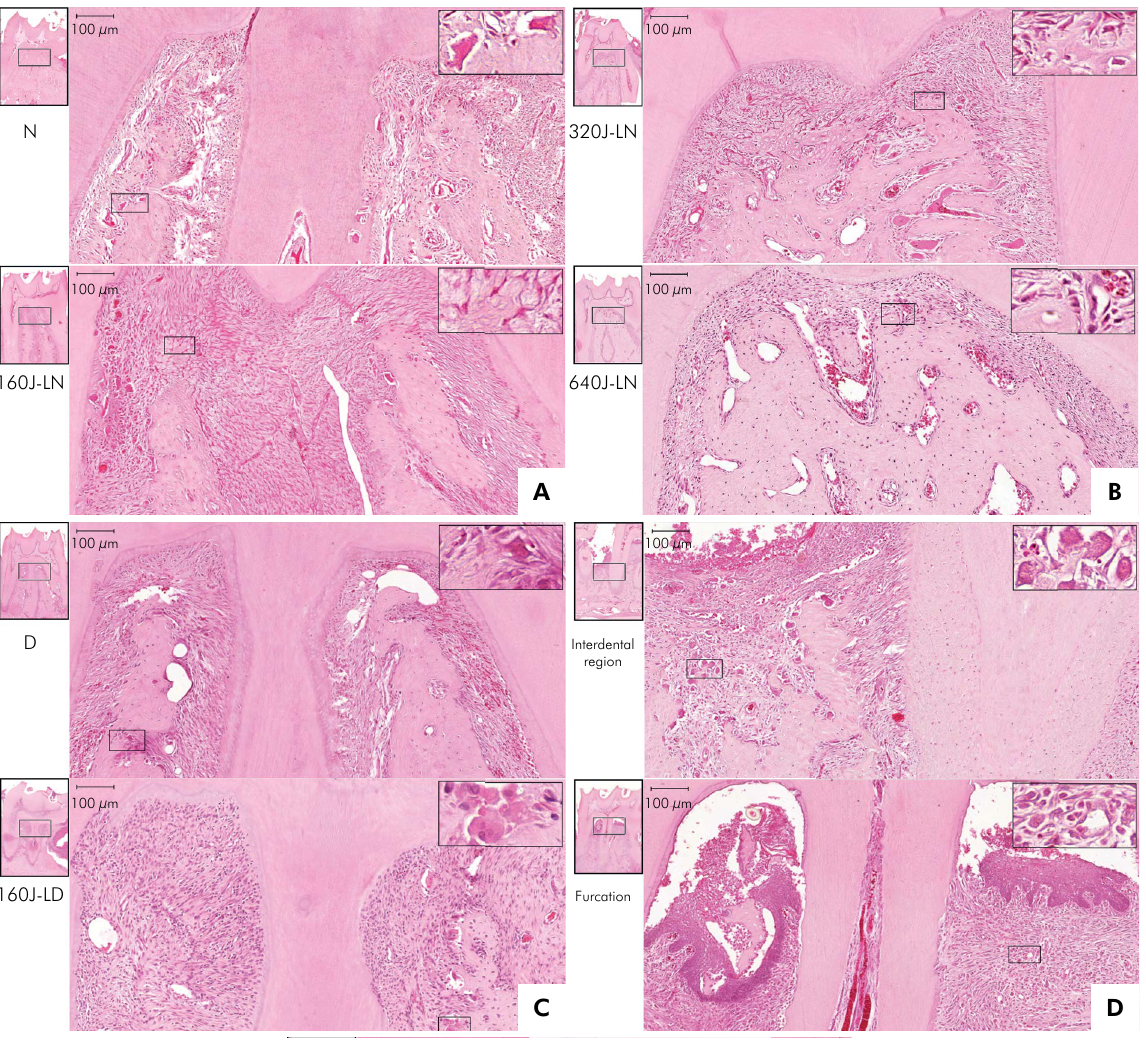
Figure 4. a) Photomicrographs showing furcation region of the orthodontically moved tooth. Intense resorption throughout the alveolar bone tissue and disorganization of the PDL tissue in the N and 160 J-LN groups; and great amount of osteogenic connective tissue showing proliferation and differentiation of news osteoblast from osteogenic cells and presence of osteoid matrix, particularly in the 160 J-LN group. (Hematoxylin and Eosin; Bars = 100 µm). b) Photomicrographs showing furcation region of the orthodontically moved tooth. Newly formed alveolar bone tissue from osteogenic connective tissue and PDL with intense cellularity and disorganized collagen fibers in the 320 J-LN group; and well-preserved and mature alveolar bone tissue, well-organized PDL tissues, and rich vascularization in the 640 J-LN group. (Hematoxylin and Eosin; Bars = 100 µm). c) Photomicrographs showing furcation region of the orthodontically moved tooth. Numerous blood capillaries, interstitial hemorrhage, and disorganized PDL in the D group; and intense osteoclastic activity eliciting accentuated alveolar bone loss in the 160 J-DL group. (Hematoxylin and Eosin; Bars = 100 µm). d) 160 J-LD group. Photomicrographs showing the interdental and furcation regions. Interdental region (between the mandibular first and second molars): degradation of the PDL tissue and intense alveolar bone resorption; and furcation region: well-cellularized and well- vascularized connective tissue replacing the interdental septum region, and apical migration of the hyperplastic junctional epithelium toward the mandibular first molar furcation. (Hematoxylin and Eosin; Bars = 100